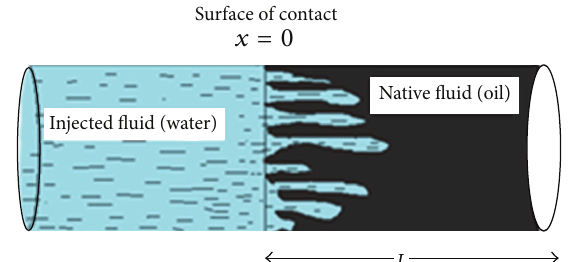
Figure 1: Representation of fingers in a cylindrical piece of homo- geneous porous media.